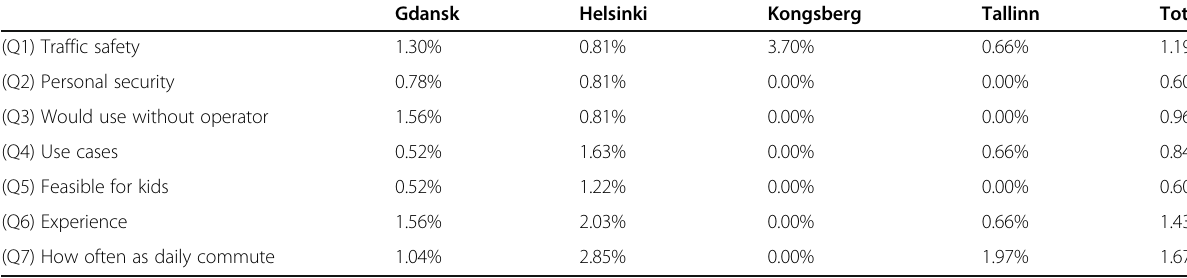
Table 2 Percentage of missing data for each question in the questionnaire